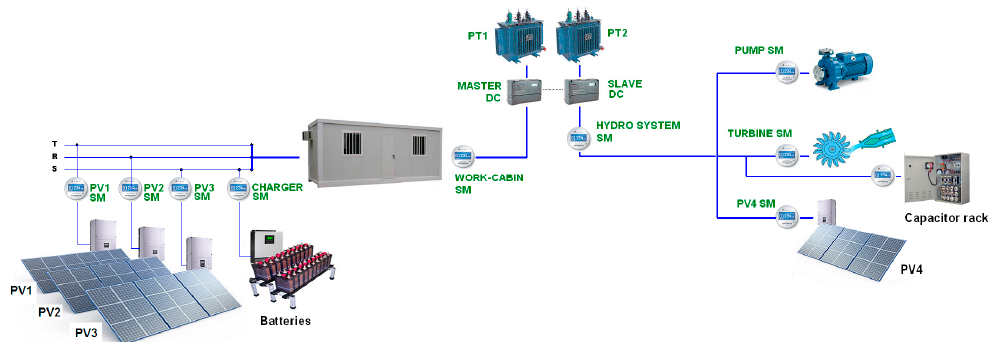
Figure 2. Simplified scheme of the measurement area. The transformation centre counts with two power transformers, located close to each other in the same transformation center, therefore leading to two electrical branches, where different DG and DS resources can be identified. Regarding electrical distances, while the SMs of the work cabin, PV1, PV2, PV3 and battery charger are approximately 13 m. away from the DC, the SMs of the hydro branch (except the hydro system SM, which is located 5 m, away from the DC) are approximately 1.5 km away from the DC.